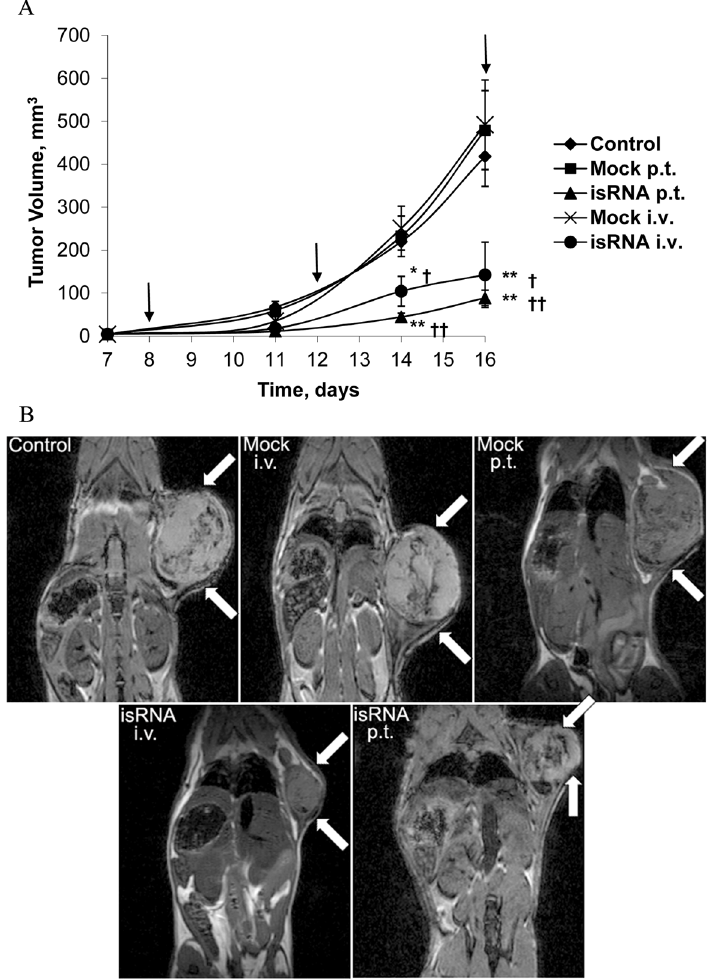
Fig 2. Treatment of melanoma B16-bearing mice with isRNA inhibits primary tumor growth. C57BL/6 mice with subcutaneous melanoma (1.5 × 105 cells per mouse) were treated with isRNA/2X3-DOPE complexes (p.t. or i.v. injections). (A) Dynamics of tumor growth. Black arrows indicate days of isRNA administration. The data represent mean ± SEM (n = 8 – 10). Statistically significant differences between experimental groups and the untreated group (control) are indicated by asterisks ( ** , P < 0.01; * , P < 0.05); and between experimental groups and the 2X3-DOPE-treated group by crosses ( †† , P < 0.01; † , P < 0.05); Mann- Whitney U test. (B) MR images of the representative mice from different groups on day 17 after tumor initiation. Frontal longitudinal sections with the maximum size of tumors from each group are shown. White arrows indicate tumor